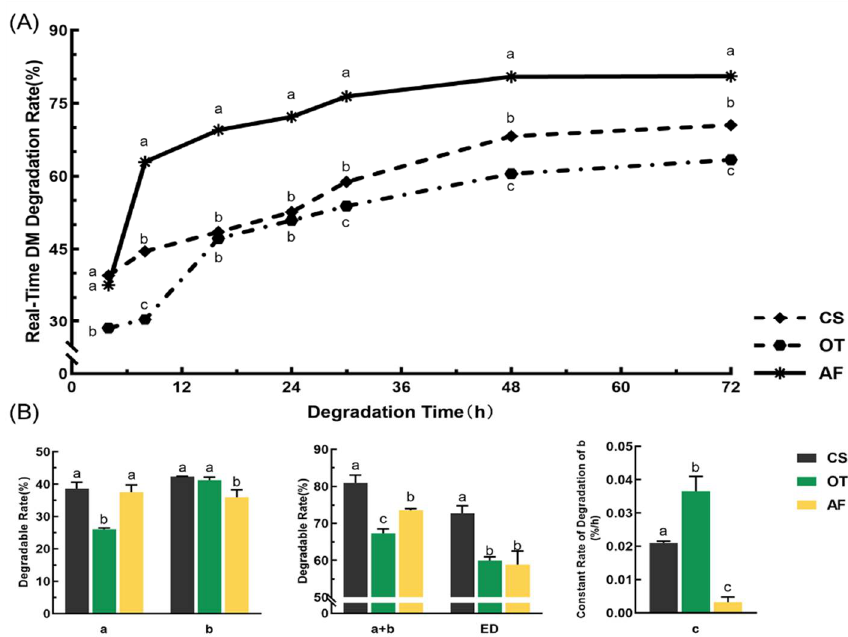
Figure 2. Rumen real-time degradability and degradation parameters of DM for three organic roughages (CS, OT, and AF). ( A ) Real-time degradation rates. ( B ) Degradation parameters. Data in the same parameter (in B ) or time points (in A ) of the superscript mark different lowercase letters indicate a significant difference ( p < 0.05). “a” (%): rapidly degradable fraction; “b” (%): the potentially degradable fraction; “c” (%/h): the constant rate of degradation of “b” (%/h); ED (%): effective degradability.